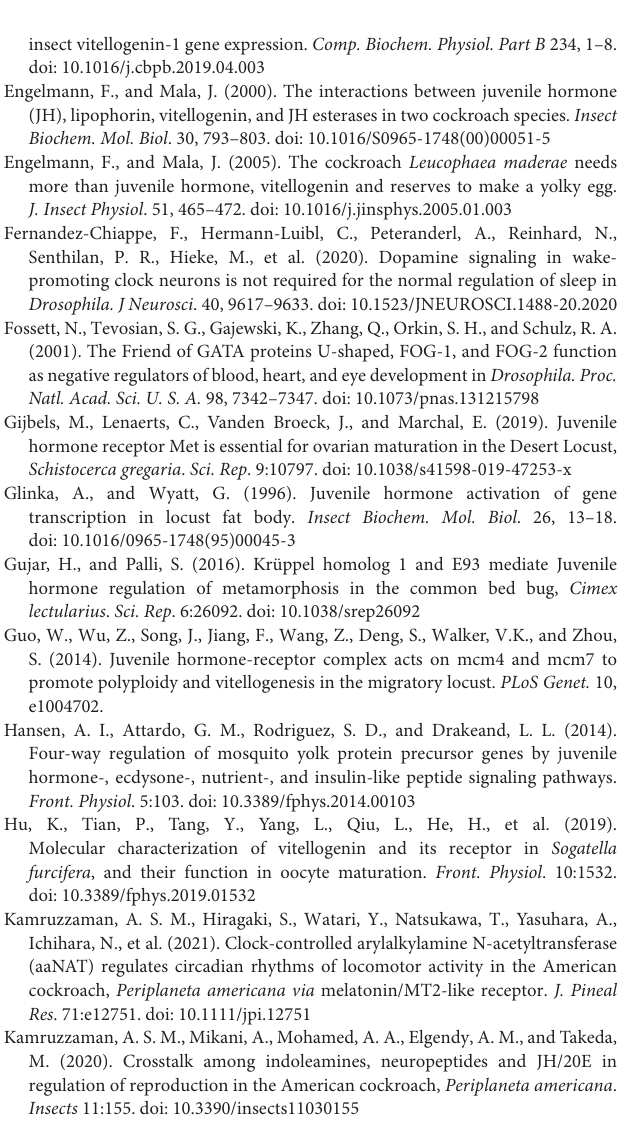
Supplementary Table 1 | List of primers and probes used in the present